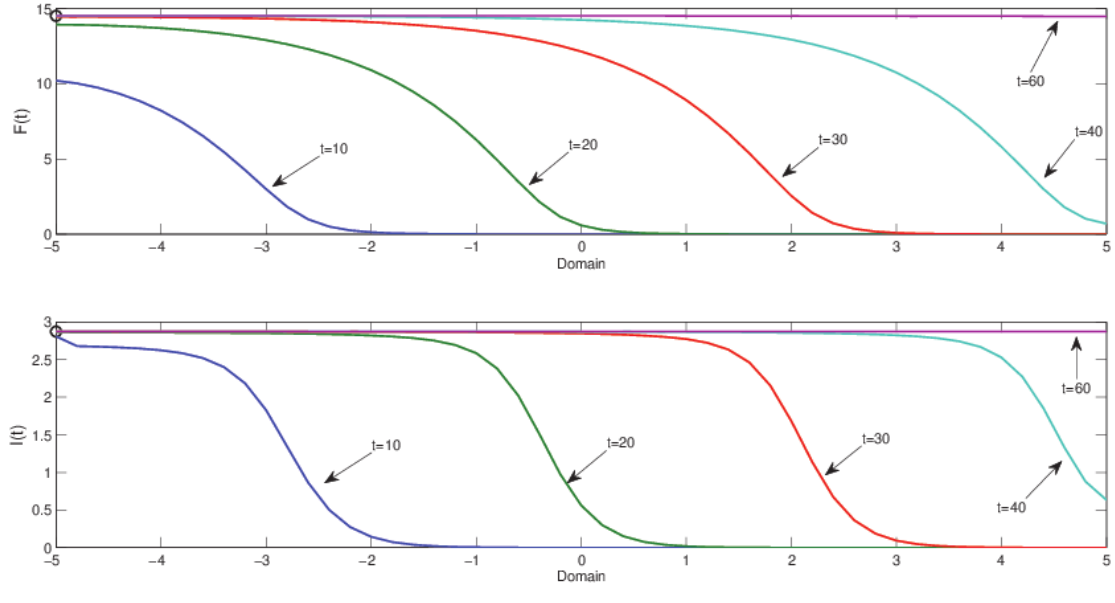
Fig. 10. When solutions of model (33) are initiated with pathogen and infectious hosts at the level of EE 2 , on the left boundary, a field of completely susceptible hosts will experience a travelling infection front. This front connects EE 2 and the PFE .